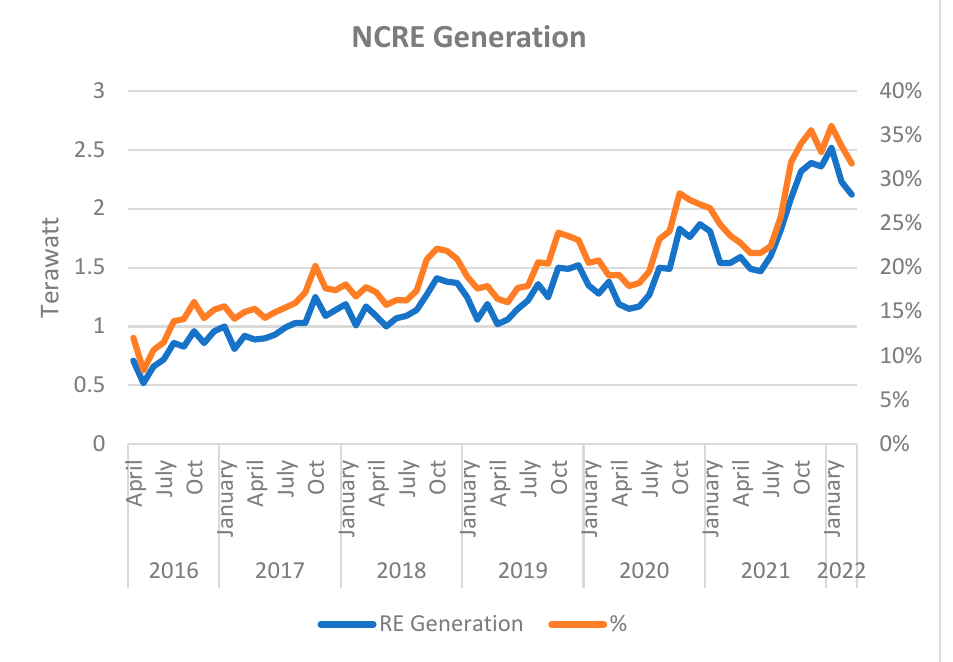
Figure 1. NCRE Generation. Source: Own elaboration based on data from the Coordinator, https://www.coordinador.cl/wp-content/uploads/2022/04/Informe-diario-20-04-2022.pdf (accessed on 5 April 2022).